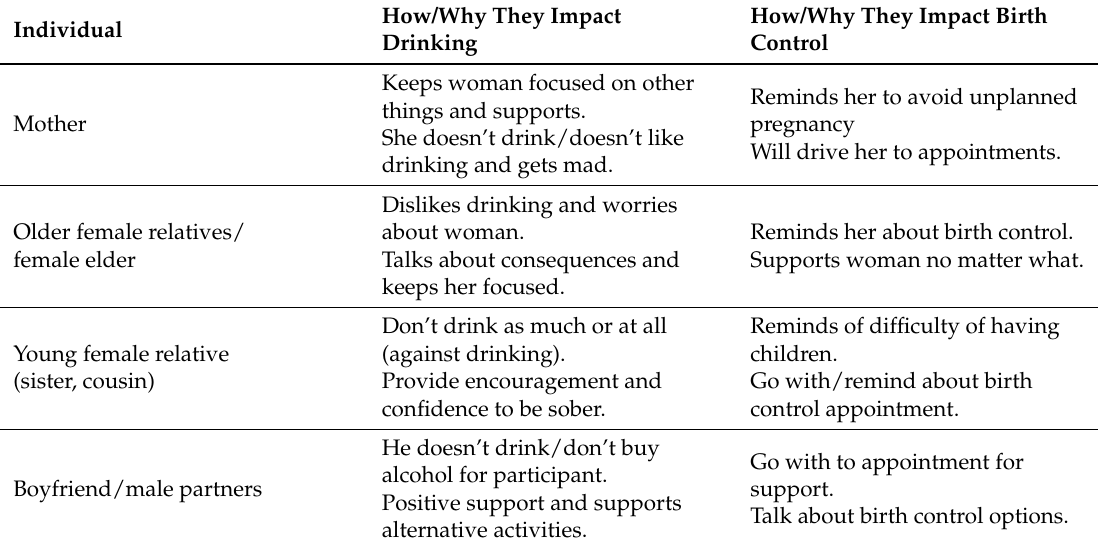
Table 1. Identified social support person and impact on